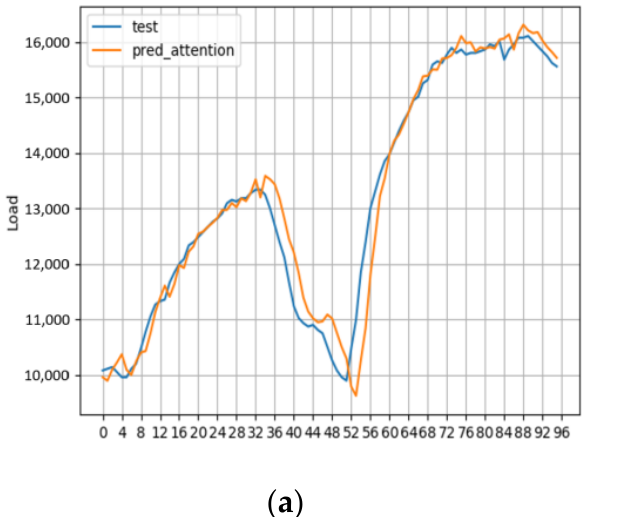
Table 3. Comparison of prediction accuracy indexes (German dataset).